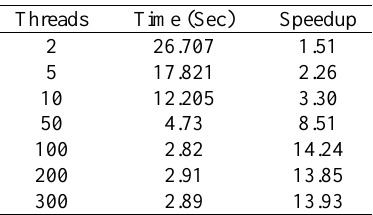
Tabel1: Speedup comparison for different number of threads in similarity and Laplacian matrix construction.